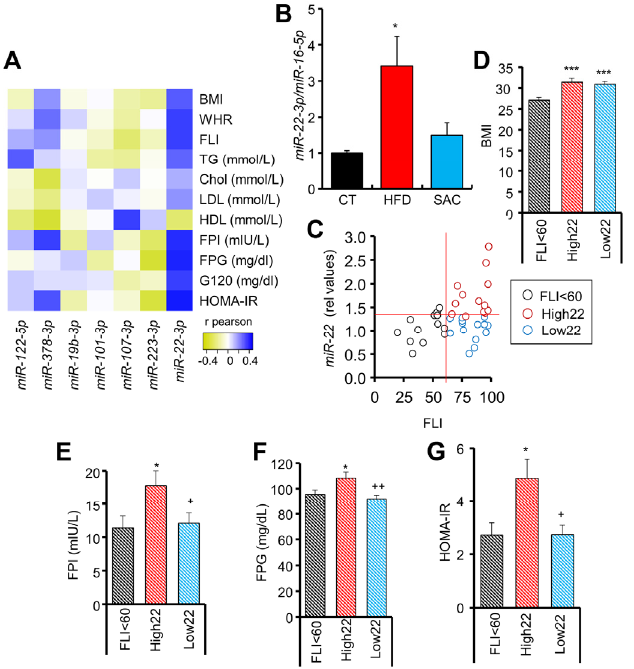
Figure 7. Circulating miR-22-3p can be used as a biomarker for MAFLD stratification. ( A ) Heatmap showing positive (blue) or negative (yellow) correlation coefficient values between circulating miR- NAs and clinical parameters in a human cohort. ( B ) Circulating miR-22-3p levels are increased in mice after 15 weeks of a HFD but not a SAC diet. ( C ) Correlation between circulating miR-22-3p and fatty liver index (FLI) in humans. ( D – G ): Individuals with FLI > 60 and high miR-22-3p levels (High22) show equivalent body mass index (BMI) ( D ) but increased fasting plasma insulin (FPI) ( E ), fasting plasma glucose (FPG) ( F ), and homeostatic model assessment-insulin resistance (HOMA-IR) ( G ) than those with FLI > 60, but low miR-22-3p levels (Low22). n = 40 ( A , C – G ), n = 3/group ( B ). * p < 0.05 and *** p < 0.005 with respect to CT or FLI < 60 group. + p < 0.05 and ++ p < 0.01 with respect to High22 group. chol = cholesterol; G120 = glucose at 120 min during oral GTT; HDL = high density lipoprotein; LDL = low density lipoprotein; WHR = waist/hip ratio.